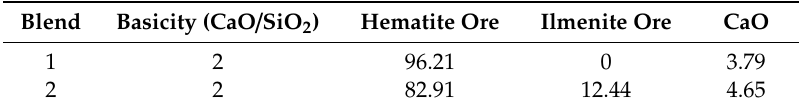
Table 2. Blending ratio of hematite ore, ilmenite ore, and CaO (wt%). Blend